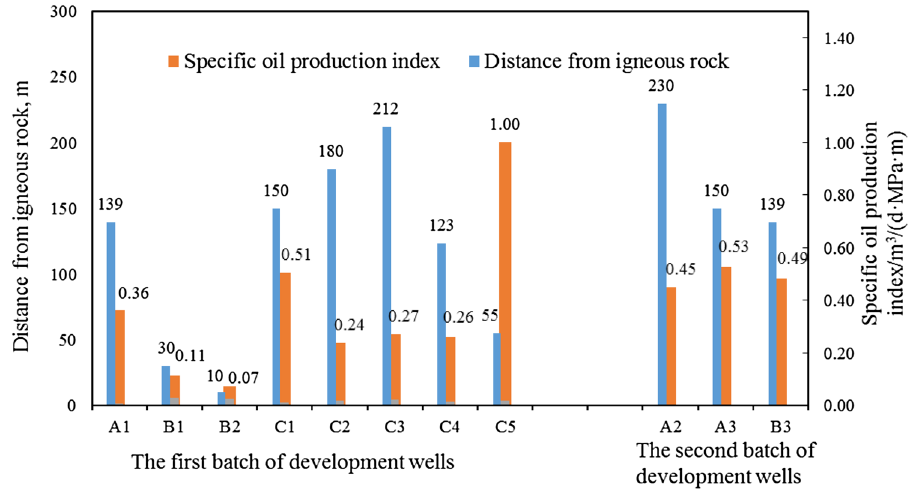
Fig. 13 Comparison of imple‑ mentation effects of the first batch of development wells and the second batch of develop‑ ment